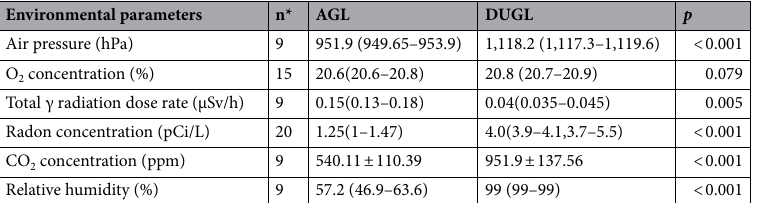
AGL. All parameters measured in the DUGL fluctuated over a small range. Cell growth and morphology.